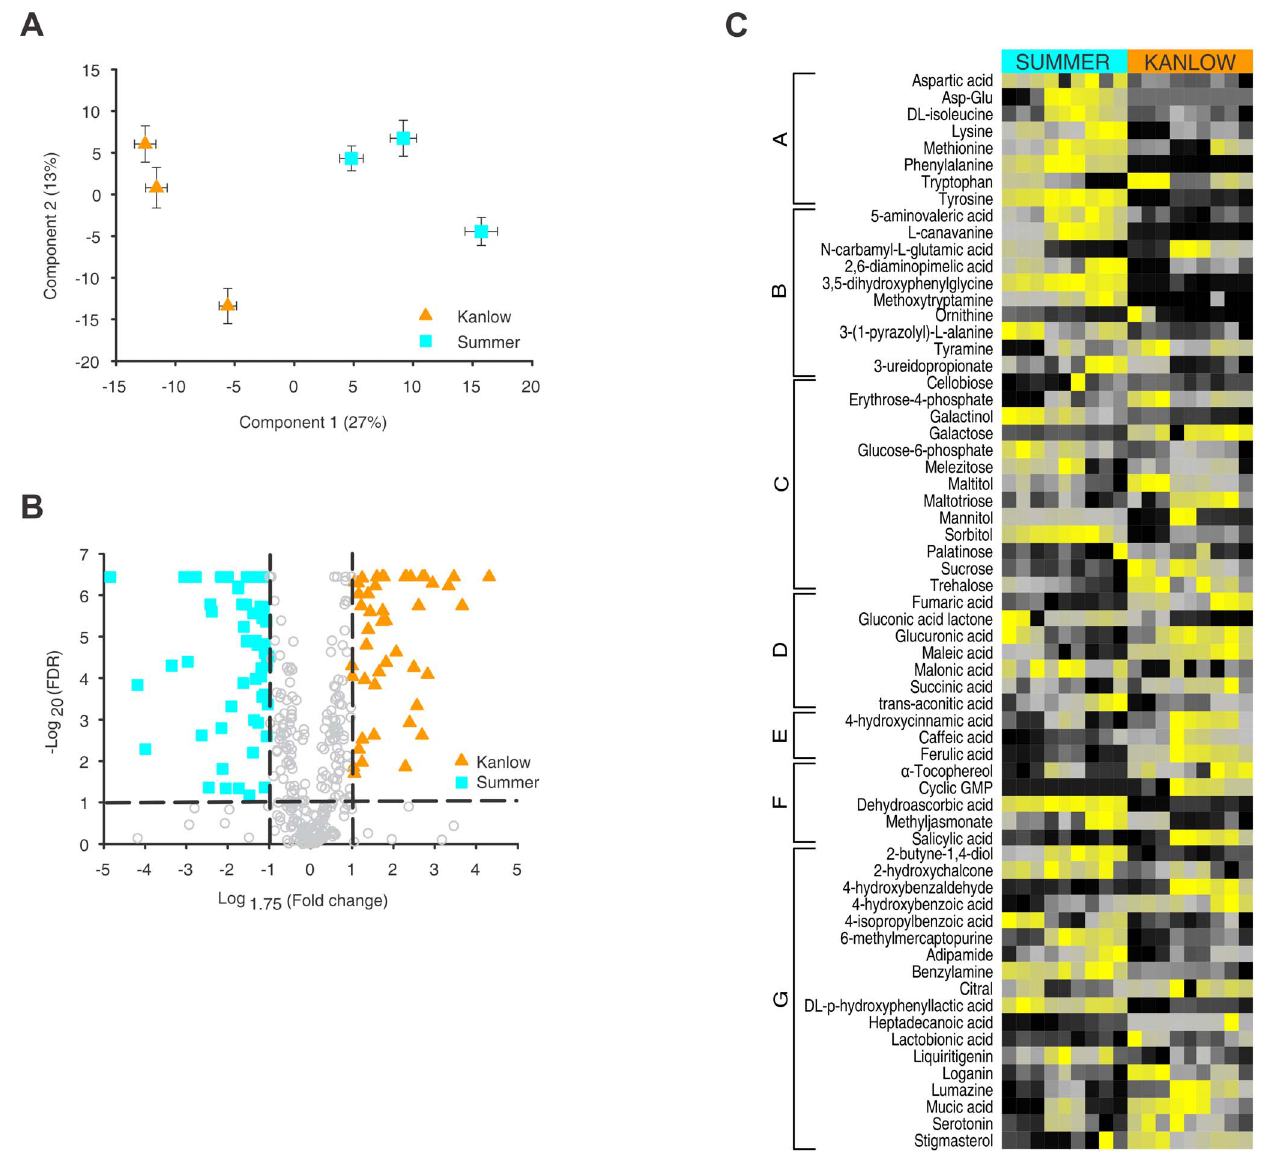
Figure 2. Metabolite profiling reveals ecotype specific differences in crown and rhizome tissues. ( A ) PCA of overall metabolite profiles observed by GCMS for for each of three individual genotypes within each cultivar. Kanlow tissue extracts (orange triangles) are separated from Summer tissue extracts (cyan squares) by the first component. Two-way error bars are shown for each plant that was based on nine separate GCMS runs for each sample. ( B ) Volcano plot showing the log 10 FDR versus the log 1.75 fold change in peak area for major ions for all metabolites detected by GCMS. Significant differences were observed for several metabolites between the two cultivars (Kanlow orange triangles) and Summer (cyan squares). Grey circles are metabolites that failed to show sufficient differences in ion area of had an FDR value of . 0.05. ( C ) Heat map shows marked differences in tissue abundances of selected metabolites in Kanlow and Summer crowns and rhizomes. Data are the average of triplicate injections from each of three separate extractions from the three biological replicates of each cultivar. Scale is from high abundance (yellow) to low abundance (black) for each metabolite. Data were subjected to one-way hierarchical clustering based on cultivar, and metabolites were manually reordered into more biologically related groupings (A–G).